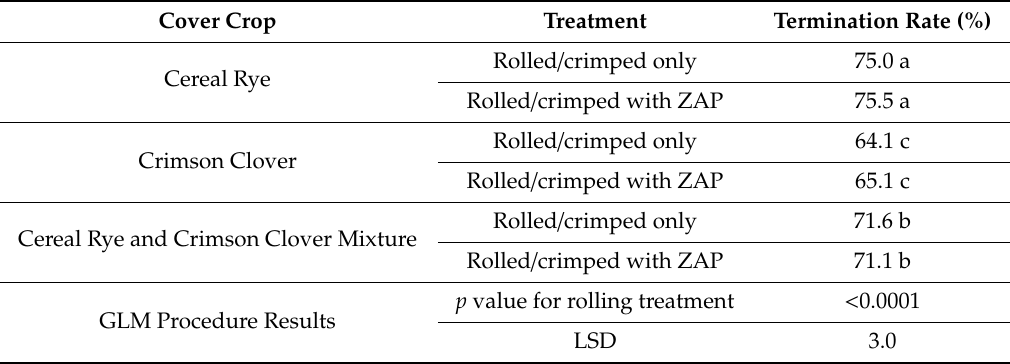
Table 4. Three-year average termination rates comparison between rolled only treatment and roller with ZAP application treatment.